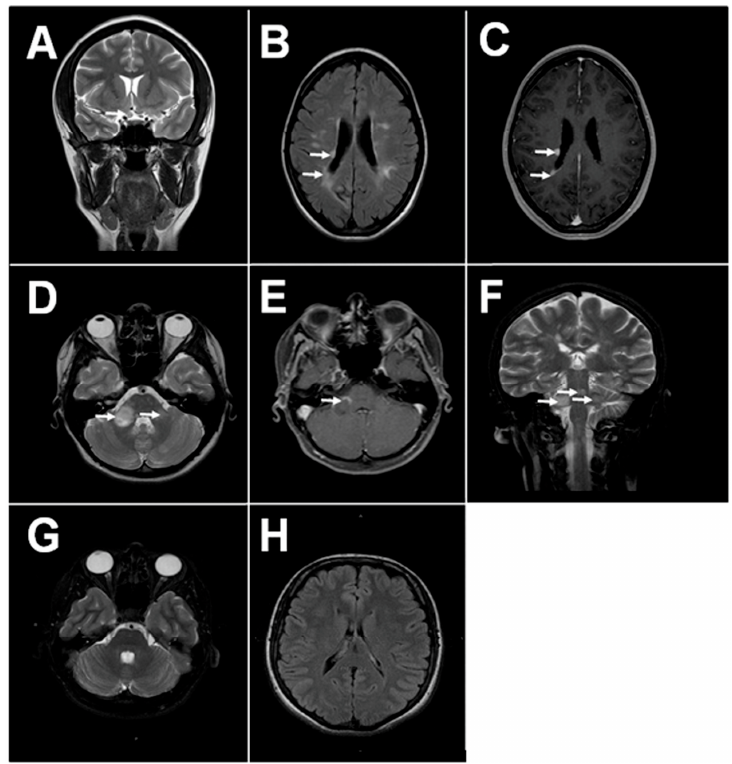
Figure 1. Magnetic resonance imaging (MRI) of MS and health brain. ( A ) Typical MS lesions in the right optical nerve on coronal T2 image; ( B , C ) Typical MS lesions in periventricular white matter on axials T2 and T1 post contrast images, respectively; ( D , E , F ) Typical MS lesions in the white matter of sub ‐ tentorial structures (pons, right middle cerebellar peduncle): on axials T2 and T1 ‐ post ‐ contrast, and coronal T2 images, respectively; ( G , H ) MRI of the healthy adult brain: normal sub ‐ tentorial structures on axial T2 images, normal periventricular white matter on axial FLAIR images, respectively.